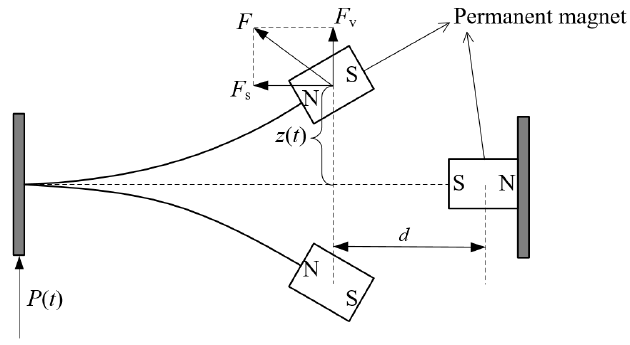
Figure 1. The bistable structural unit.